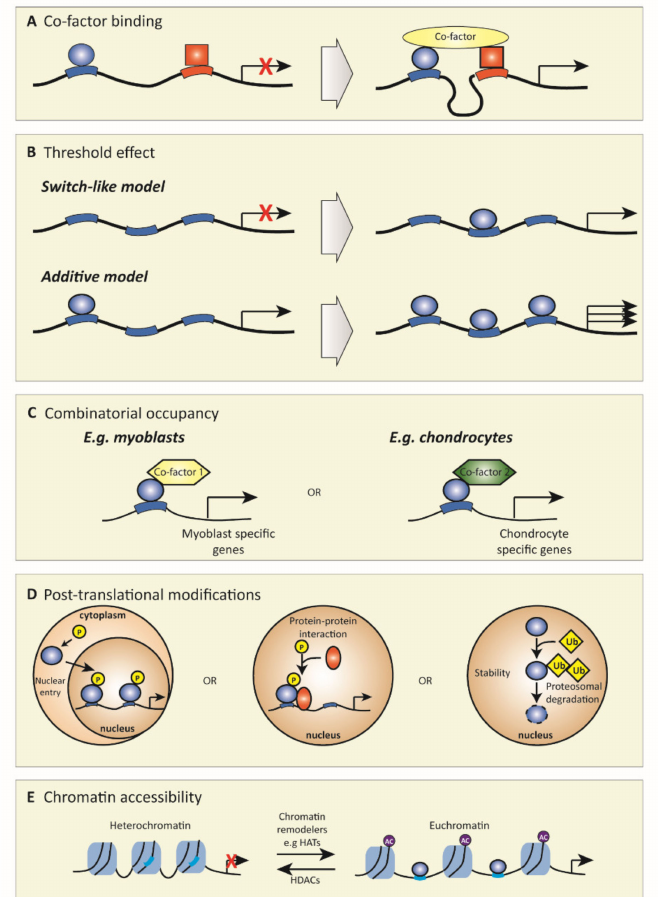
Figure 1. A schematic depiction of different mechanisms of transcription factor function. Models of how transcription factors can affect transcription by ( A ) cofactor binding, ( B ) threshold effect, ( C ) combinatorial occupancy, ( D ) post-translation modifications, and ( E ) chromatin accessibility. ( A ) Some transcription factors need cofactors to activate transcription. For example, cofactor binding can create a looping of the DNA, which brings transcription factors that are normally far apart into close proximity, which results in activated transcription. ( B ) For some genes, transcription is an on / off switch where, in the absence of transcription factors, no transcription occurs, while above a certain concentration binding of transcription factors results in transcription (switch-like model). For other genes, binding of more transcription